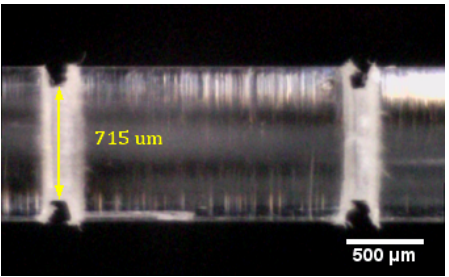
Figure 2. Cavities milled in the fiber. The fiber has a diameter of 1mm, and the cavity depth is 137.5µm. The separation of the cavities is approximately 2mm.